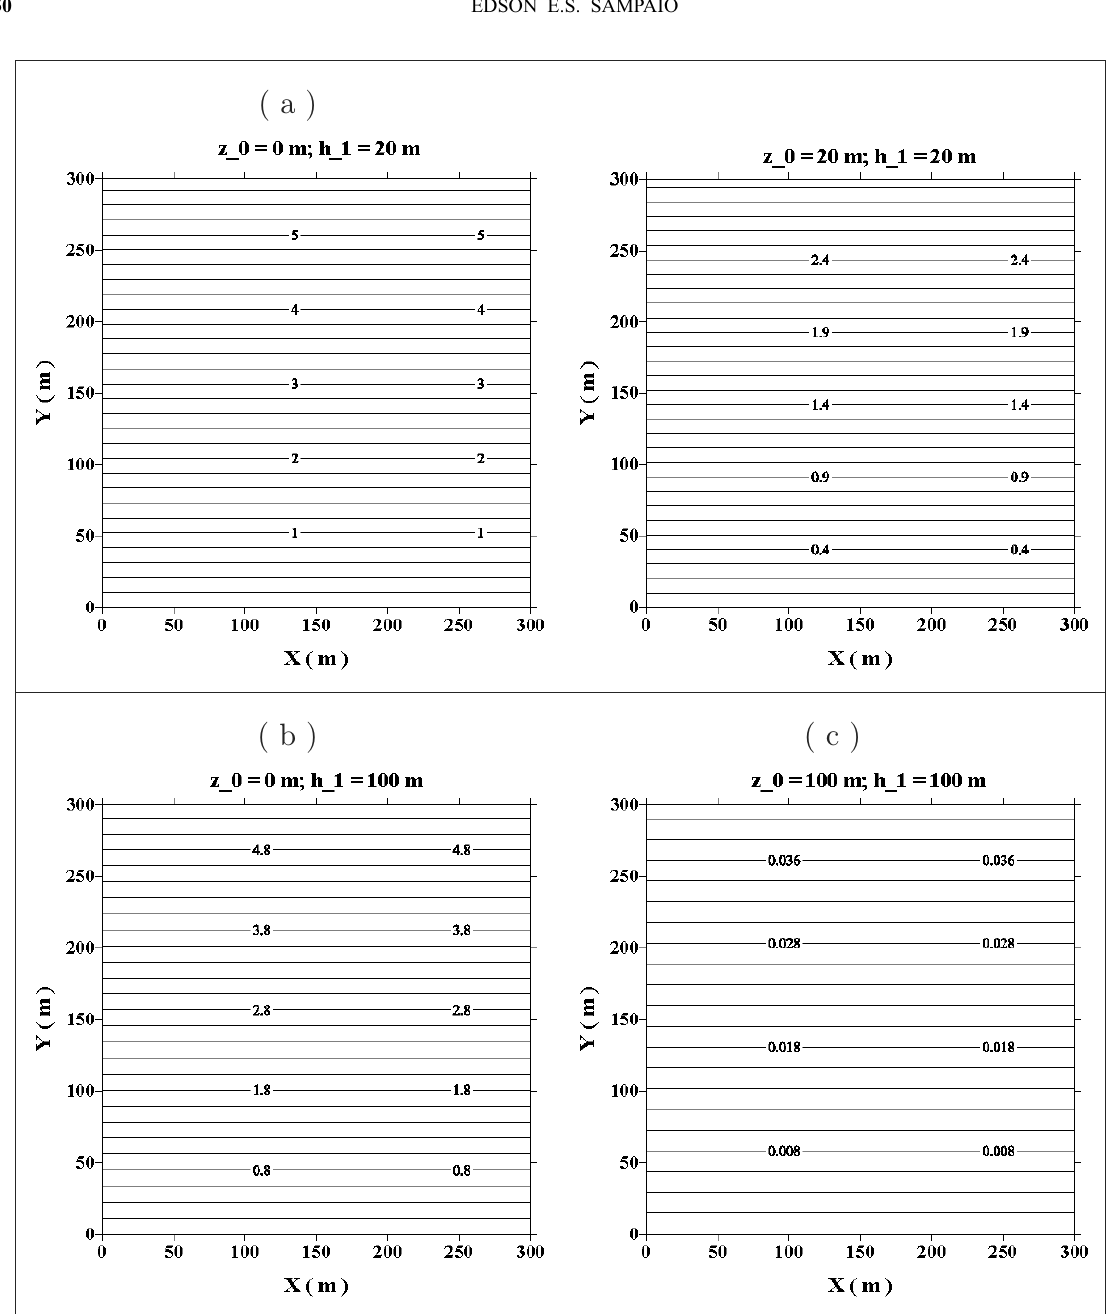
Fig. 9 – Contour maps of the difference of the vertical component of the magnetic field in nanotesla between one substratum with σ 2 = 0 . 3 S/m and another with σ 2 = 0 . 003 S/m. h 1 represents the thickness of the sea